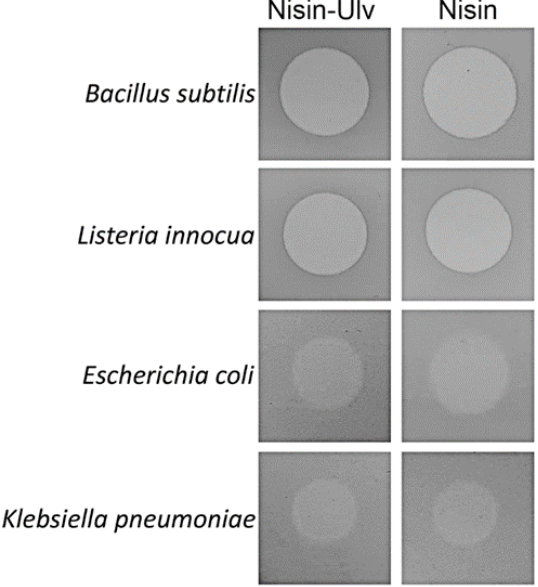
Figure 6. Bacteria sensitivity to nisin-loaded nanoparticles. The inhibitory activity of encapsulated (Nisin-Ulv) and free nisin was demonstrated by measuring growth inhibition zones in agar diffusion assay. Free nisin concentration was 0.2 mg/mL; nisin-loaded ulvan particles were prepared using the same concentration of nisin. Table 2. Minimum inhibitory concentration of free and encapsulated nisin.